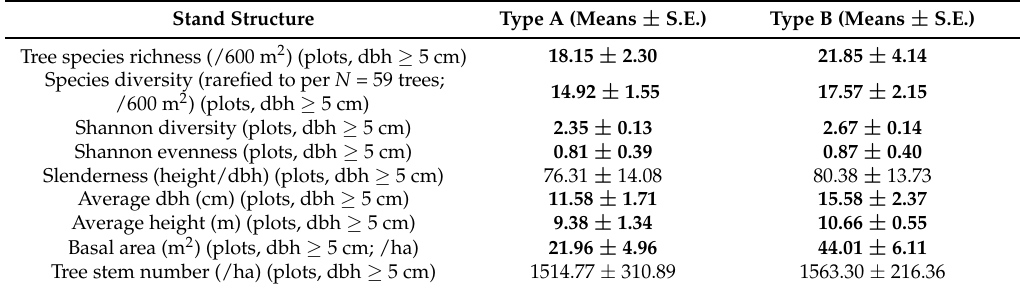
Table 1. Structural and diversity parameters for forest types A (ridges) and B (valley) at altitudes of 200–1200 m a.s.l. Means ± S.E. are given. Significant differences ( p < 0.05) between the two forest types are indicated in bold